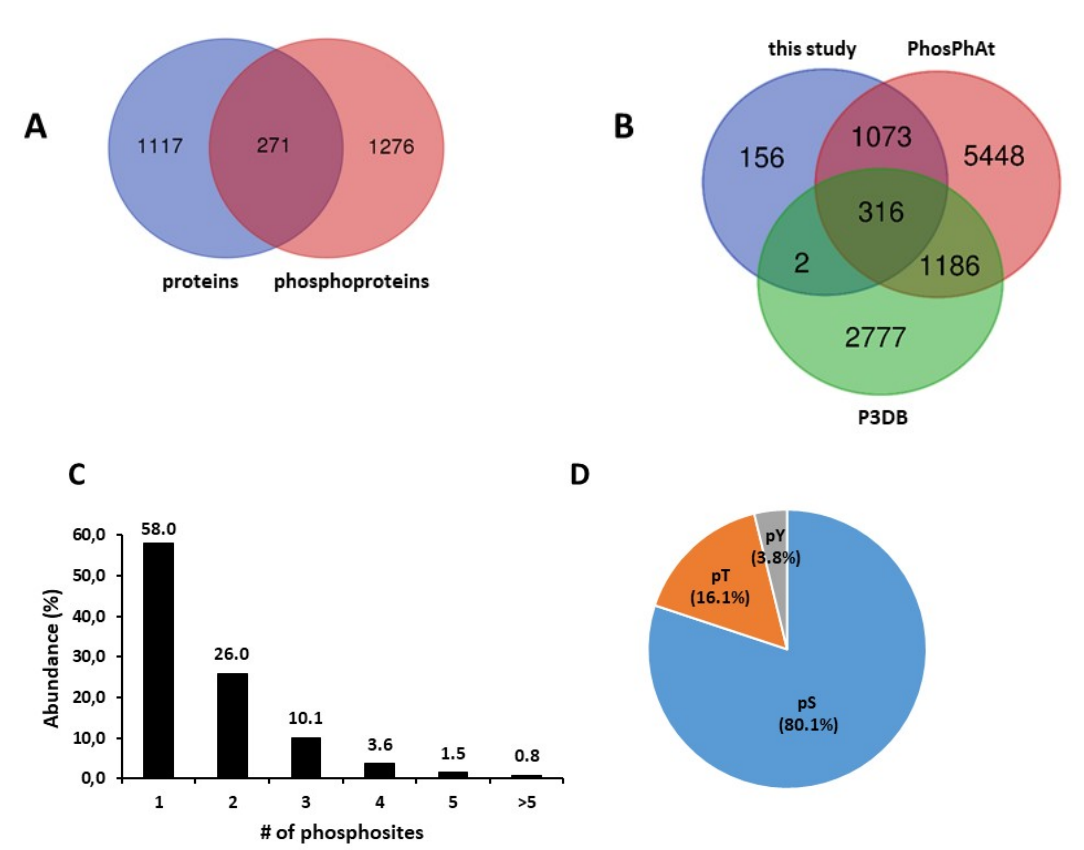
Figure 3. Overview of the seed proteome and phosphoproteome. ( A ) overlap of proteome and phosphoproteome. ( B ) overlap of identified phosphoproteins with known phosphoproteins from PhosPhAt 4.0 and P3DB databases. ( C ) distribution of phosphoproteins according to the number of phosphosites identified. ( D ) Relative abundance of serine, threonine, and tyrosine phosphosites.